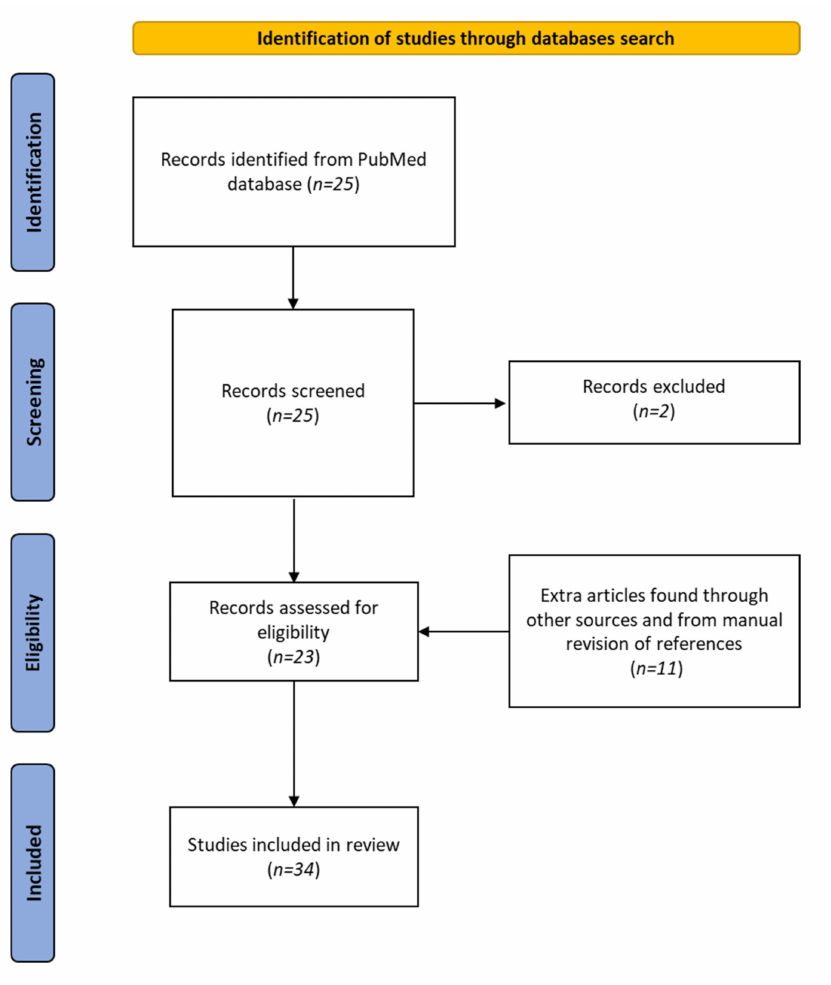
Figure 2. PRISMA 2020 flow diagram of the literature-search